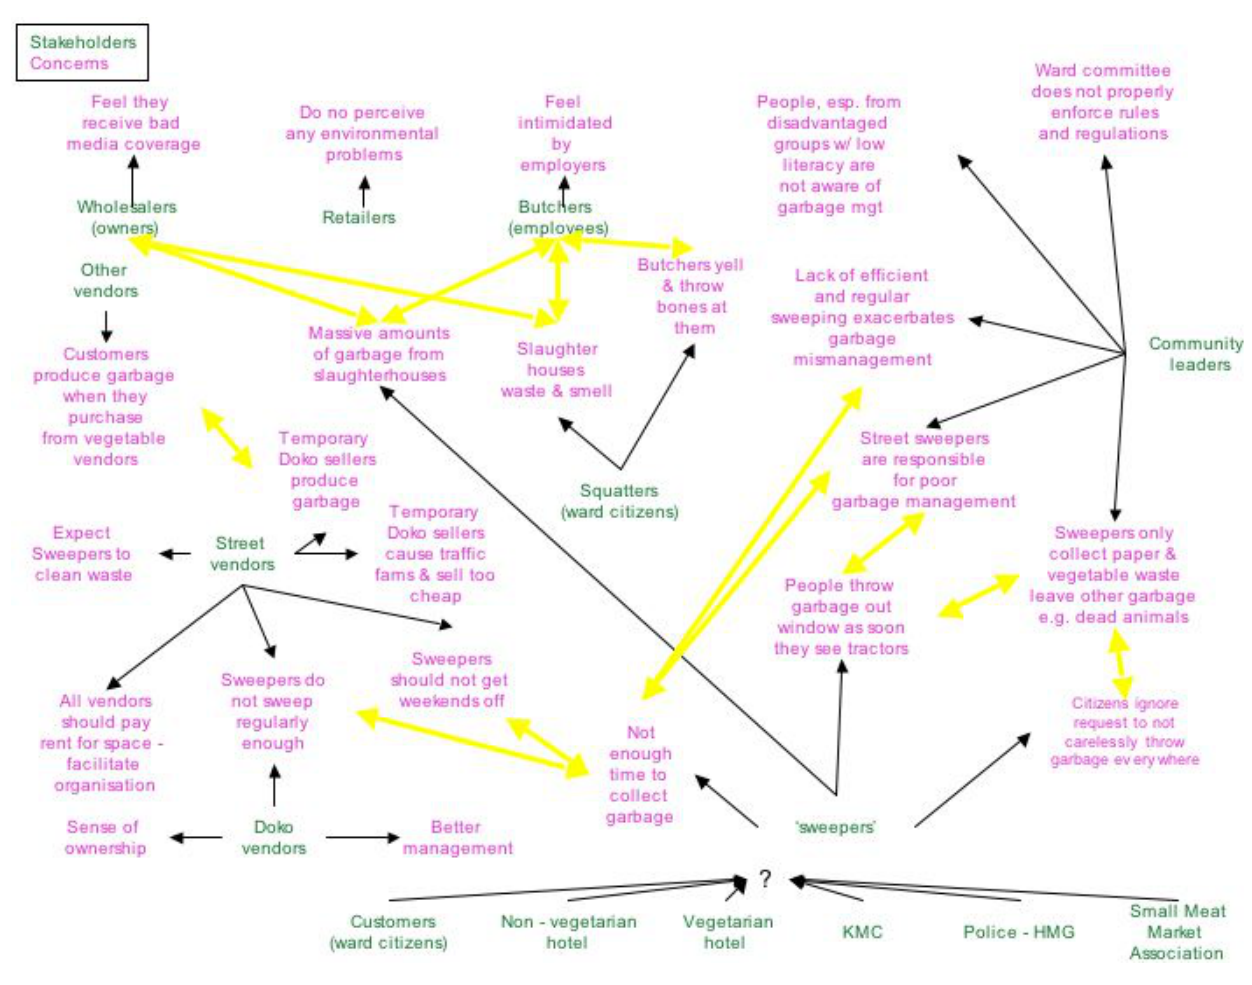
Fig. 8 . Stakeholder concerns - food and waste